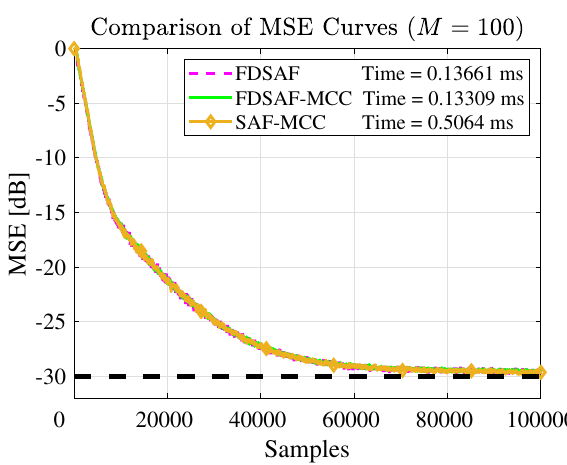
Figure 3. Experiment 1: Comparison of MSE curves of FDSAF, FDSAF-MCC, and SAF-MCC algorithms without non-Gaussian